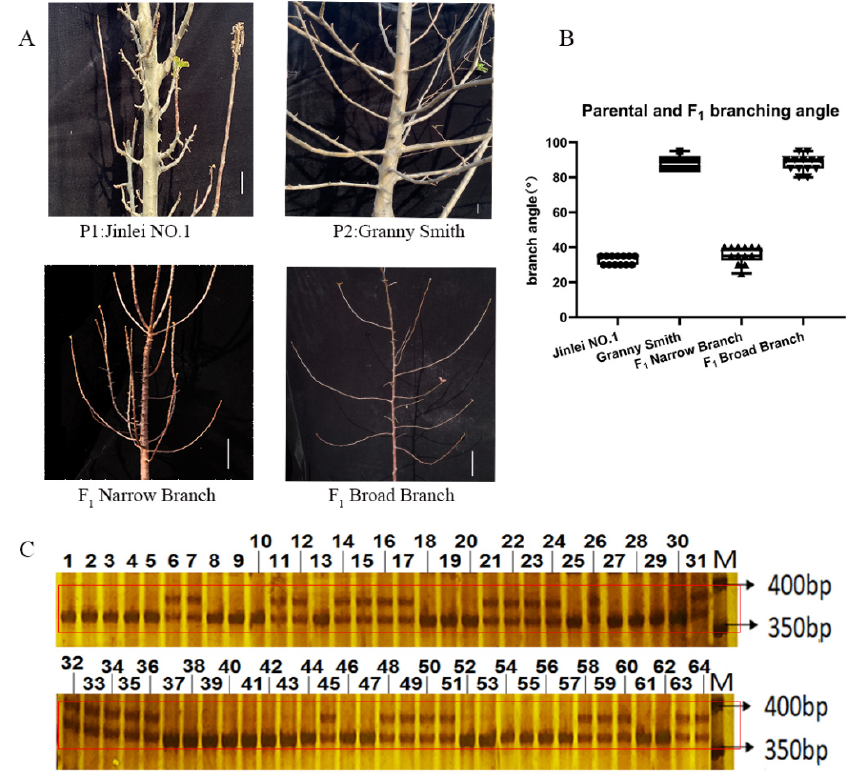
Figure 8. Genotyping of TAC1a in apple parental and F 1 individuals by an InDel marker. ( A ) Apple parental and F 1 individuals. ( B ) was the branch angle statistics of the parents and F 1 . ( C ) was the separation of TAC1a marker in the parental and F1 progeny. M represented DNA ladder marker;L ine 1 to 29 and line 32 to 64 represented F 1 generation; 30 represented parental Granny Smith; 31 represented parental Jinlei No. 1 The parent and F 1 were separated at 400 bp of the red box in Figure ( C ).